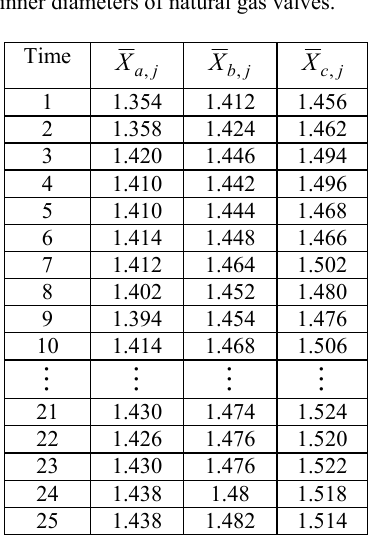
Table 3. Fuzzy arithmetic means ),,( XXX for each sample for the ,,, jcjbja inner diameters of natural gas valves.